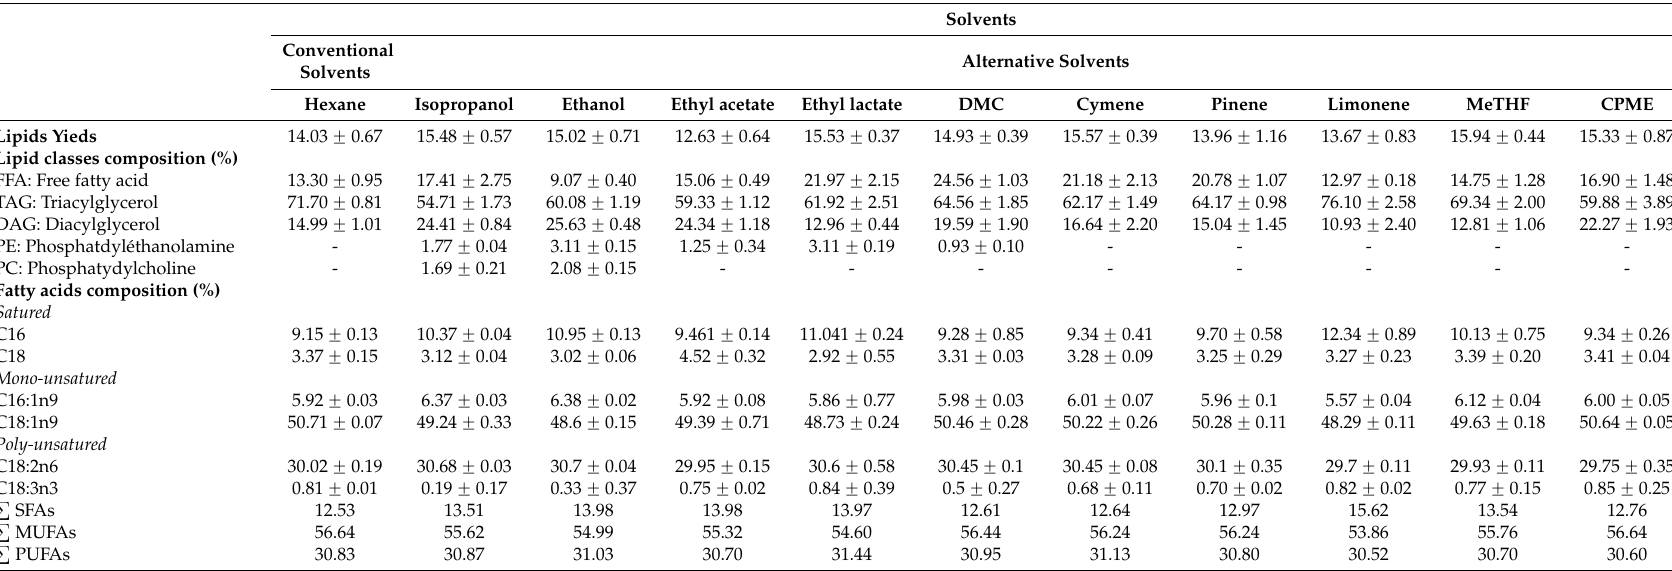
Table 1. Crude lipids, distribution of lipid classes and fatty acid compositions of extracts obtained by extractions with different solvents (PUFAs, polyunsaturated fatty acids; MUFAs, monounsaturated fatty acids; SFAs, saturated fatty